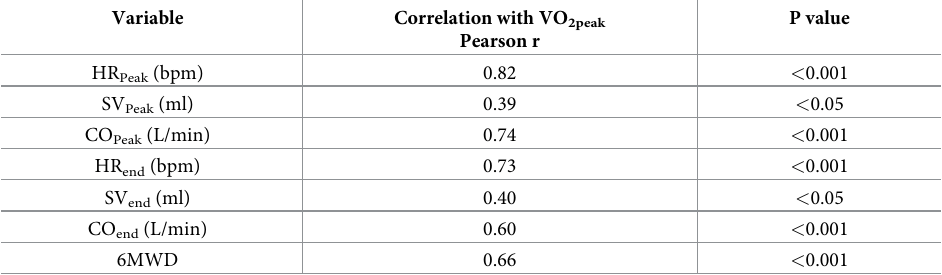
Table 3. Correlation between VO 2peak and 6MWD, maximal HR, SV and CO during both 6MWT and CPET. Variable Correlation with VO 2peak Pearson